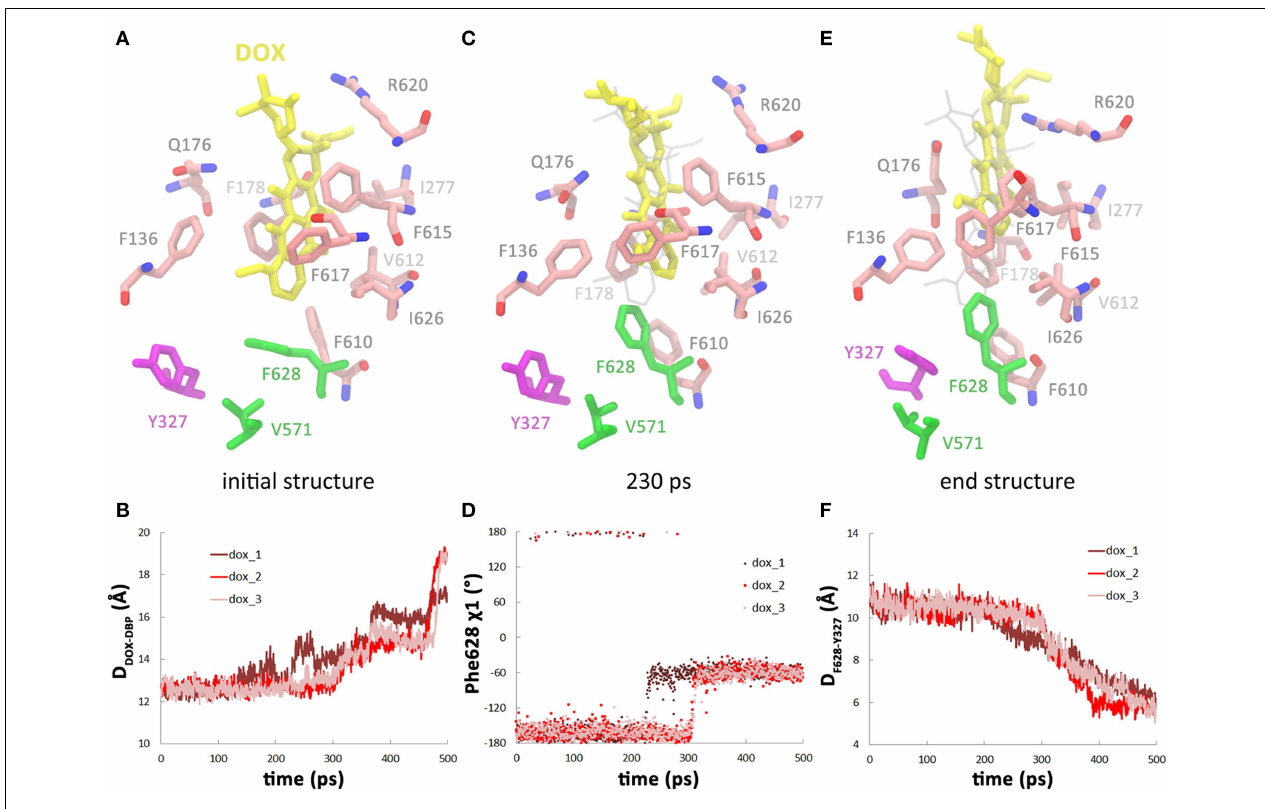
one of the trajectories when Phe628 reoriented and pointed toward the substrate. (D) Variations of χ 1 angle of Phe628 along the simulation trajectories. (E) Close view of doxorubicin and the residues lining DBP at the end of the simulation when Tyr327 inserted in between Phe628 and Val571. (F) Variations of the distance between the mass center of Tyr327 side chain and the C α atom of